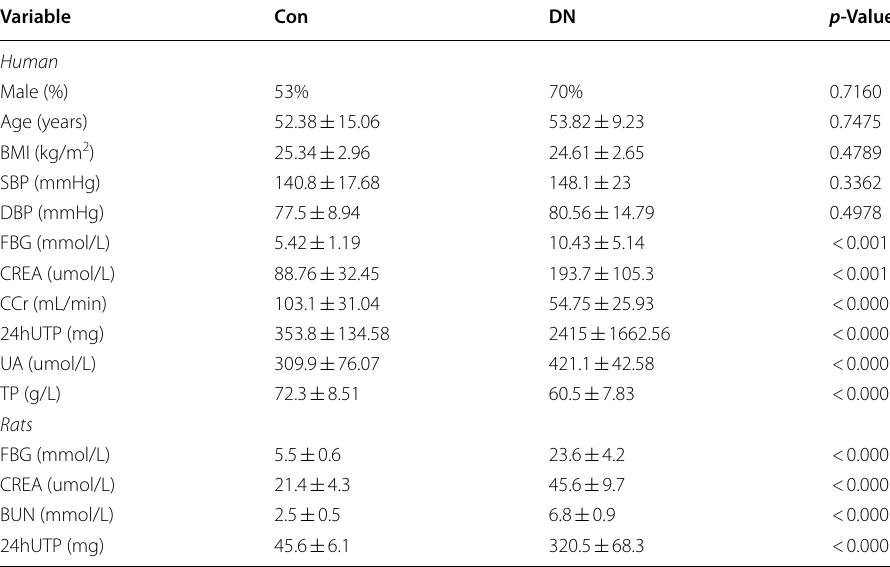
Table 1 Characteristics of participants and rats in control (con) and diabetic nephropathy (DN)